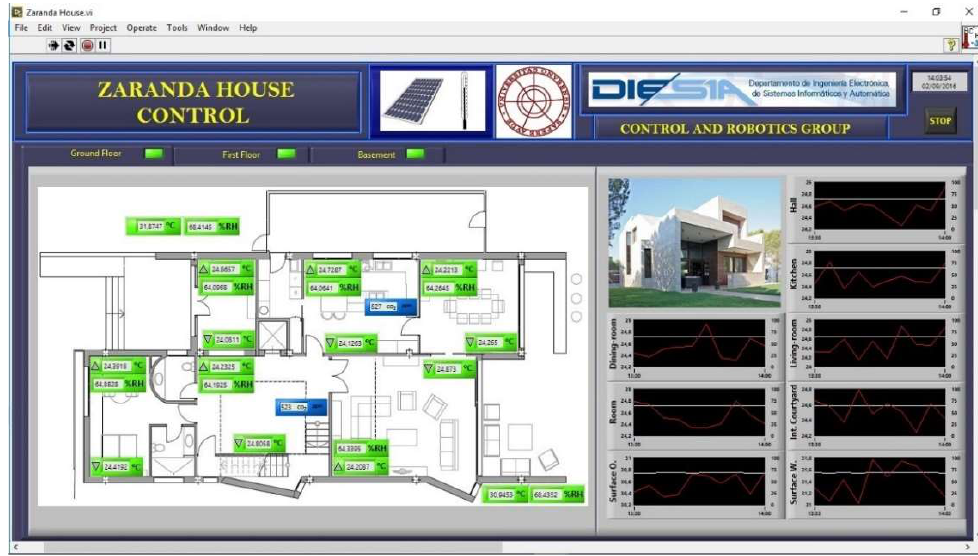
Figure 13. Location of sensors (T, RH, and CO 2 ) on the ground floor.